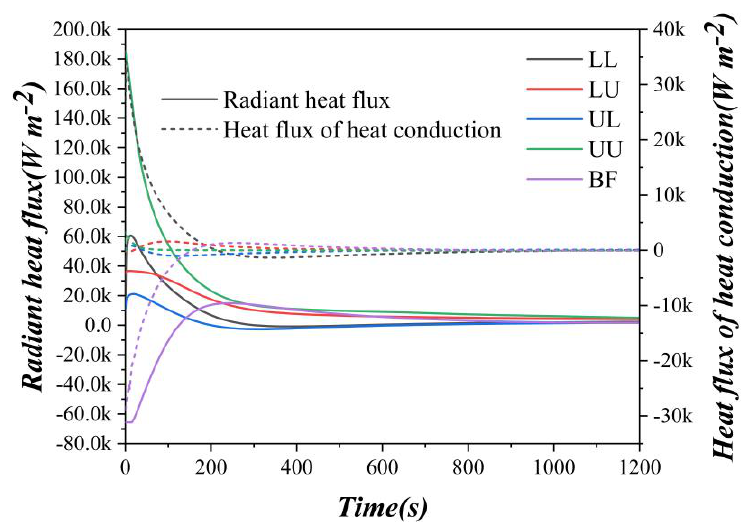
Figure 9. Variations of heat flux (radiation and heat conduction) at di ff erent bed Figure 9 . Variations of heat flux (radiation and heat conduction) at different bed locations.